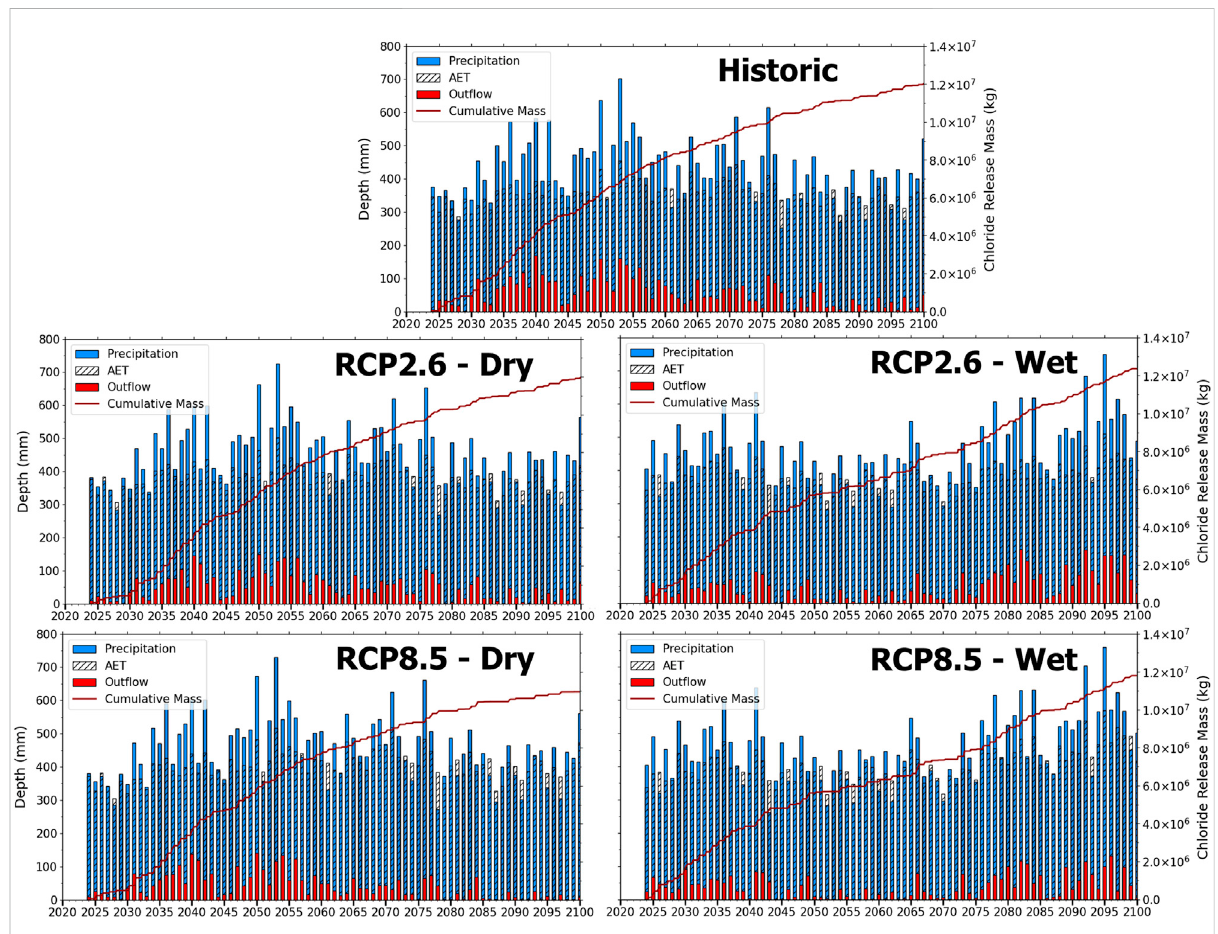
FIGURE 7 Precipitation, out fl ow, actual evapotranspiration (AET) and chloride mass loading for the fi ve model